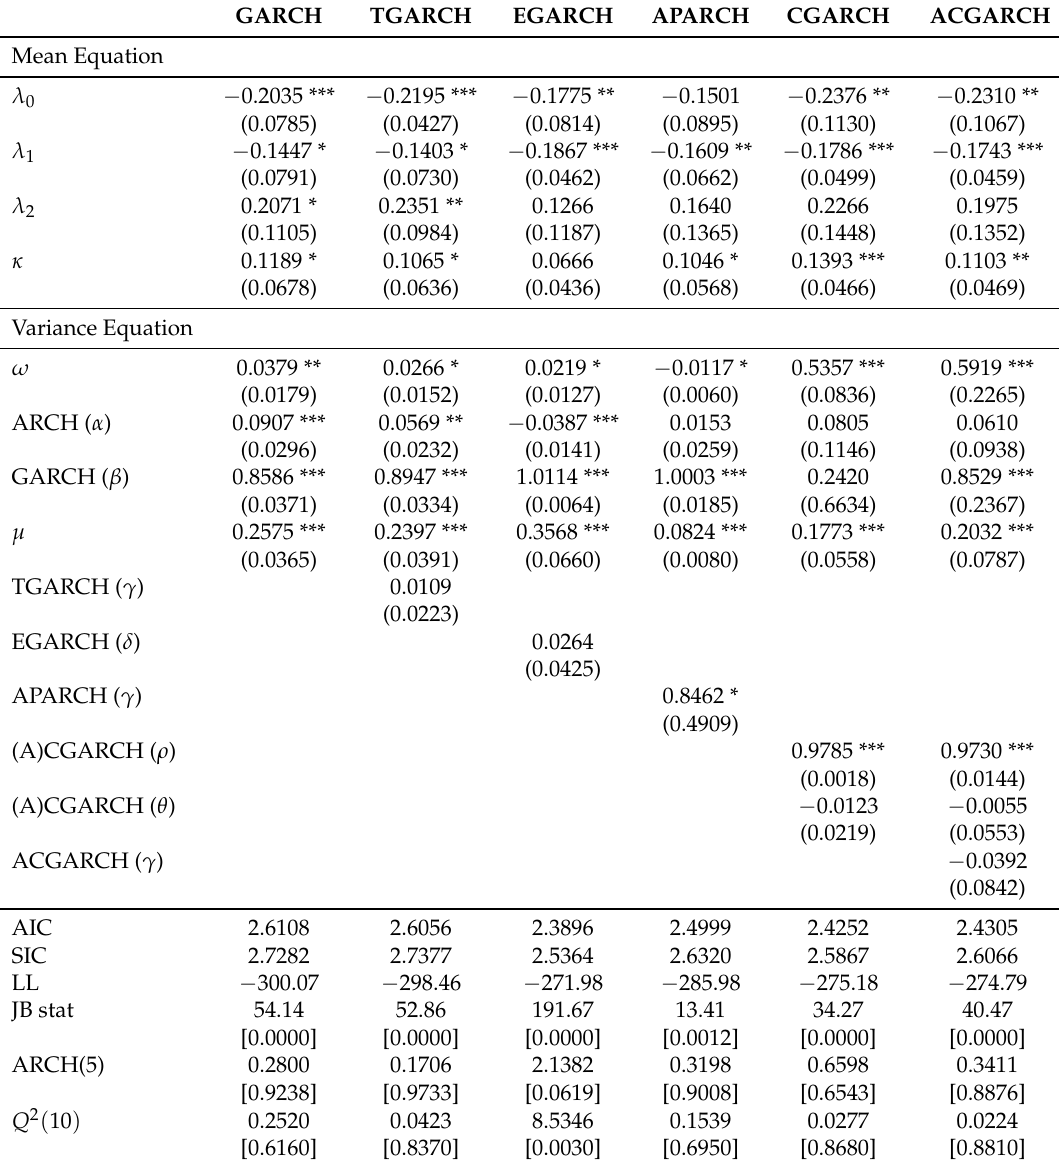
Table A11. GARCH-M Tests for Ethereum for the recovery